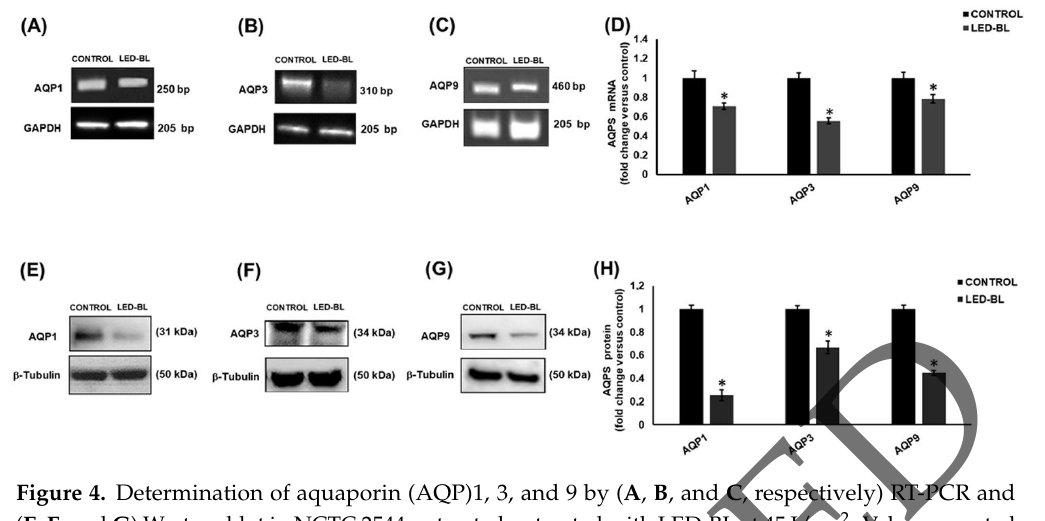
Figure 4. Determination of aquaporin (AQP)1, 3, and 9 by ( A , B , and C , respectively) RT-PCR and ( E , F , and G ) Western blot in NCTC 2544 untreated or treated with LED-BL at 45 J/cm 2 . Values reported in ( D ) for RT-PCR and ( H ) for Western blot, respectively, were expressed as fold change versus untreated control. * Significant versus untreated control; p < 0.05.